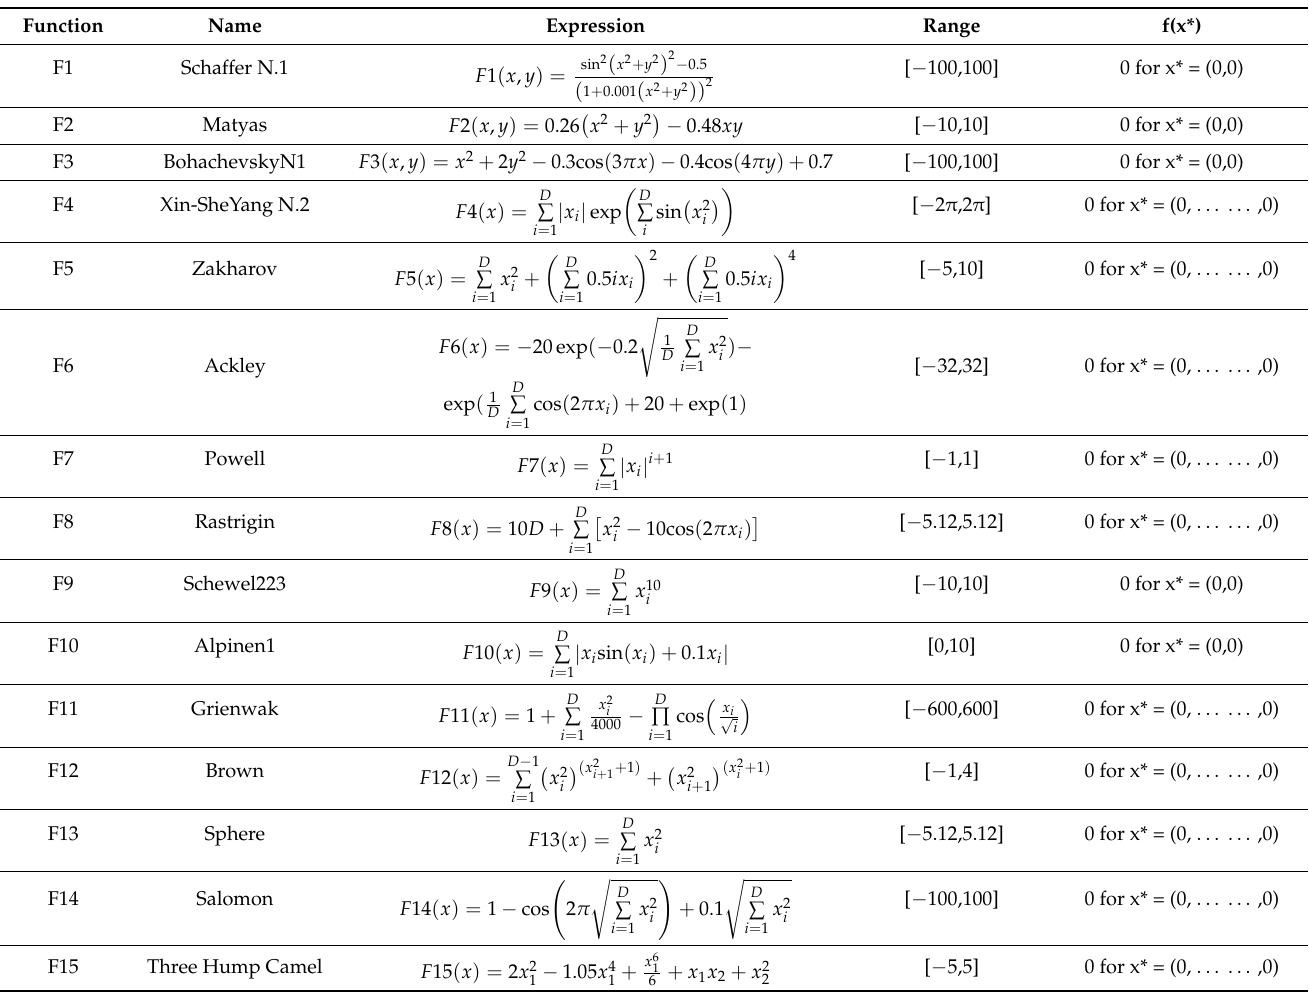
Table 1. Benchmark functions.